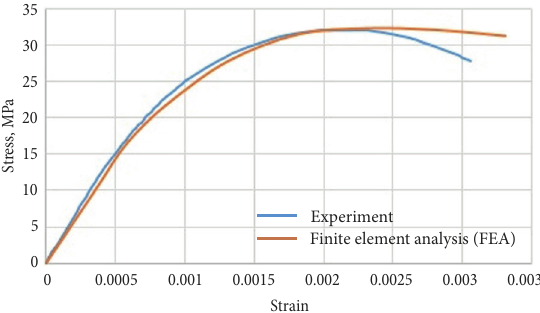
Fig. 10. Comparison of stress-strain responses of current study and experiment (Kupfer, Gerstle 1973) in biaxial compression test